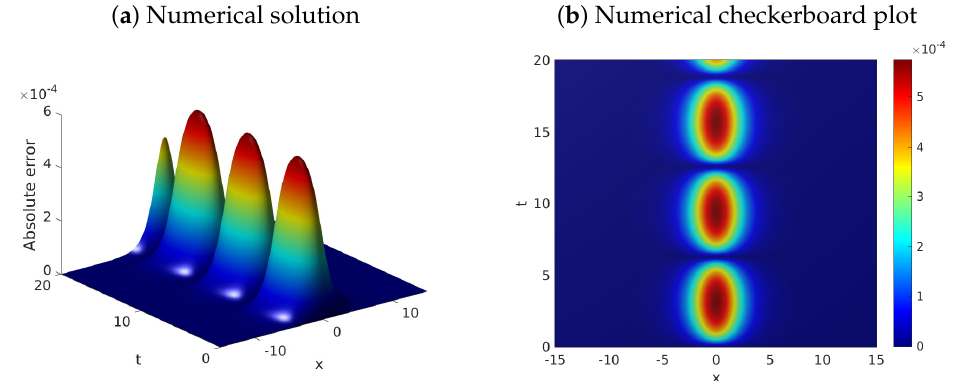
Figure 3. Graph of the point-wise absolute error between the exact analytical solution obtained in Figure 2 and the corresponding numerical approximation. The error was calculated in the infinity norm of R 2 at each point on the spatial domain and at the time T = 20. For convenience, we provide the three-dimensional plot (left column) and the corresponding interpolated checkerboard